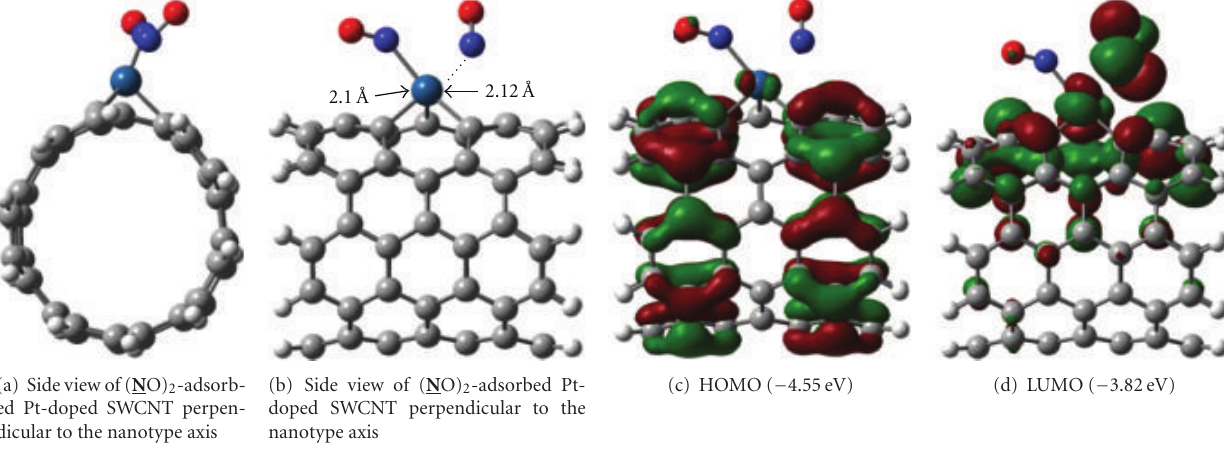
Figure 23: Optimized geometry of ( N O) 2 -adsorbed HSWCNT. Orbital energies are in parentheses [113]. Legend: dark grey = carbon, light grey = hydrogen, navy blue = nitrogen, red = oxygen, blue = platinum.